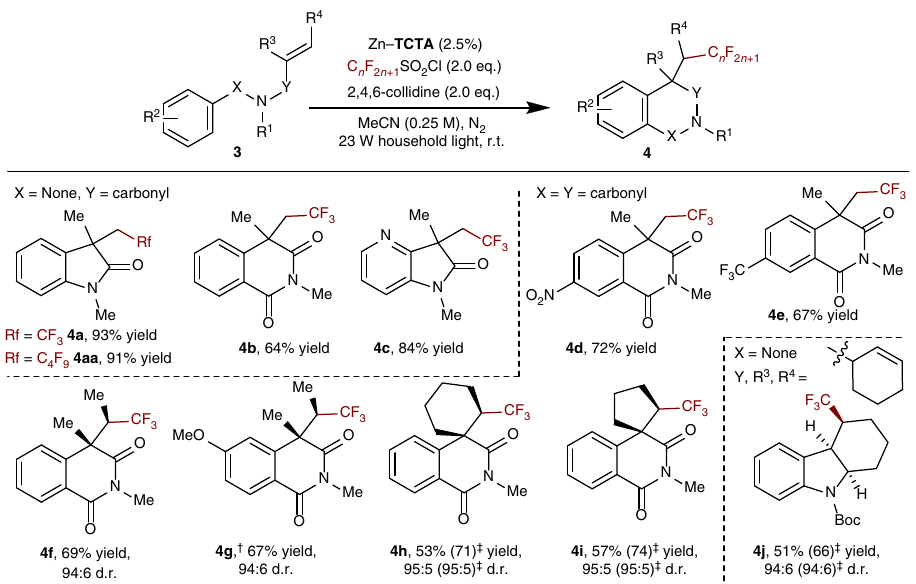
Fig. 6 Photocatalytic alkenyl tri fl uoromethylation-arylation by Zn – TCTA . Conditions were the same as those in Fig. 5. Isolated yield. † 1.5 or ‡ 3.0 equiv of TfCl and